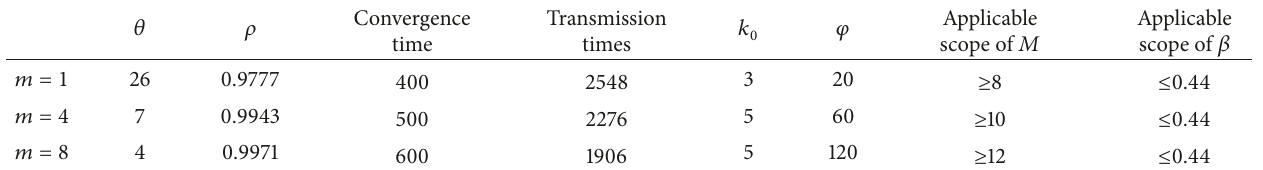
Table 2: Comparison of the parameters under different 𝑚